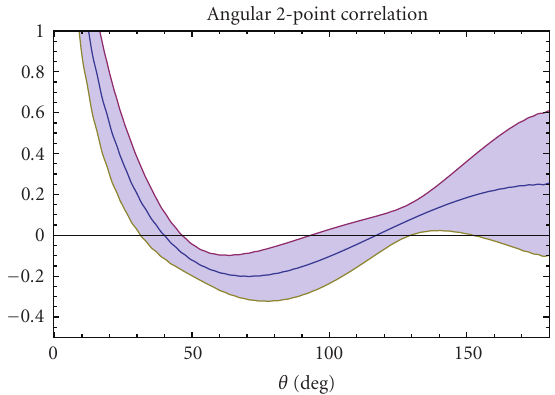
Figure 2: Mean and (cosmic) variance of the angular two- point correlation function as expected from cosmological inflation (arbitrary normalization). Only statistical isotropy, Gaussianity and scale invariance are assumed. Tensors, spectral tilt, reionization and the integrated Sachs-Wolfe e ff ect are neglected for the purpose of this plot. Comparison to the prediction from the best-fit Λ CDM model (Figure 5) reveals that these corrections are subdominant. Note that cosmic variance errors at di ff erent values of θ are very highly